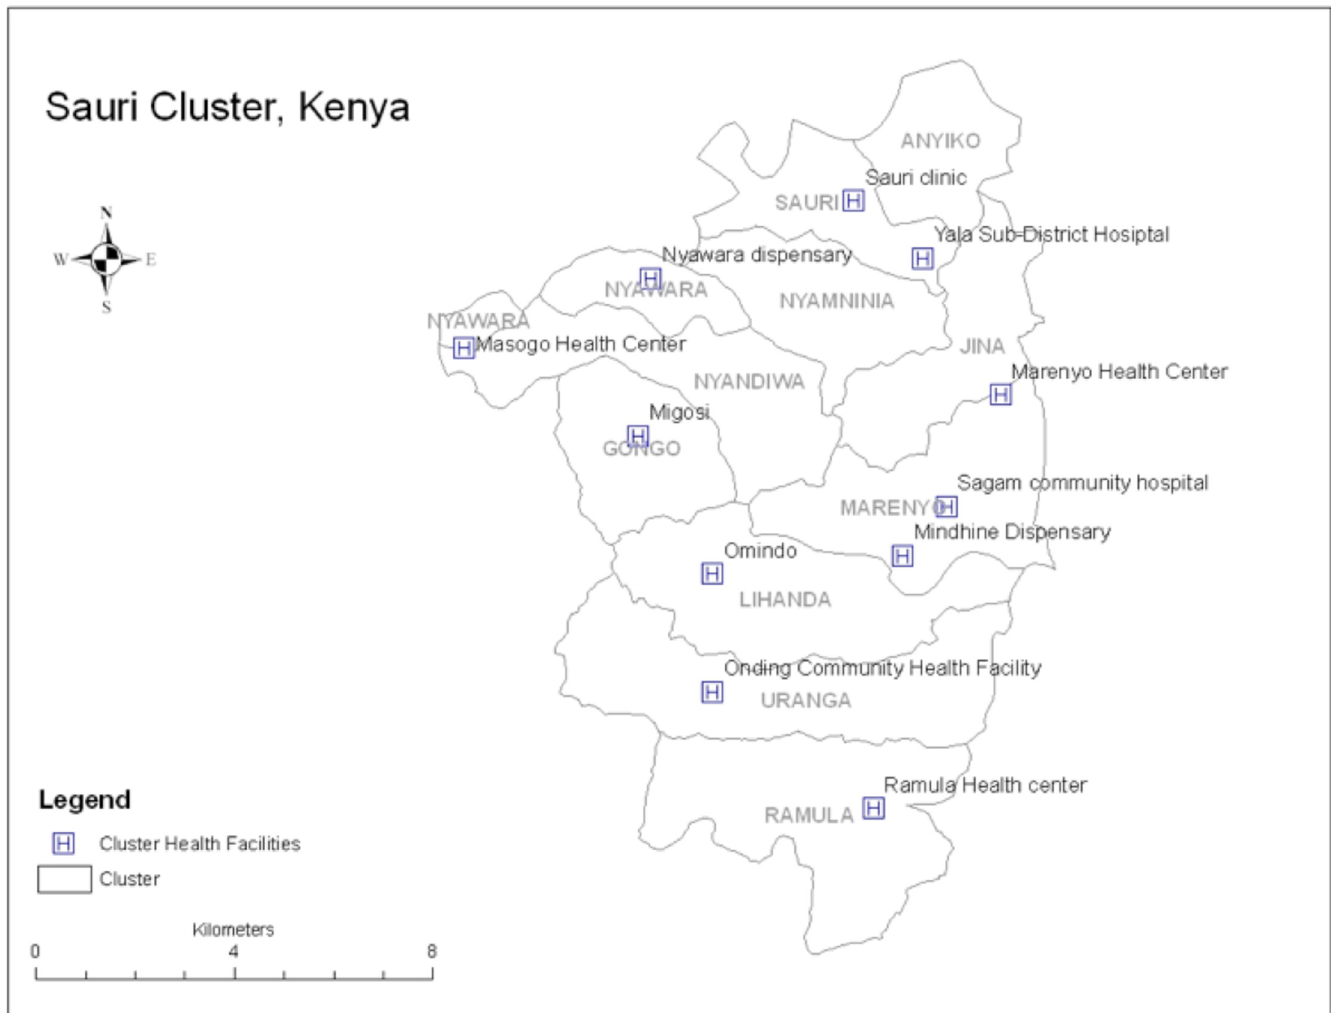
Fig 1. Map of the Sauri cluster. The MVP site in Kenya is divided into 12 sub-locations including Sauri, and is dubbed “Sauri Cluster” because Sauri was where the inception of the package of MVP comprehensive development interventions was first implemented. Each sub-location with its own network of CHWs and the Cluster has 10 health facilities in total, including a sub-district referral